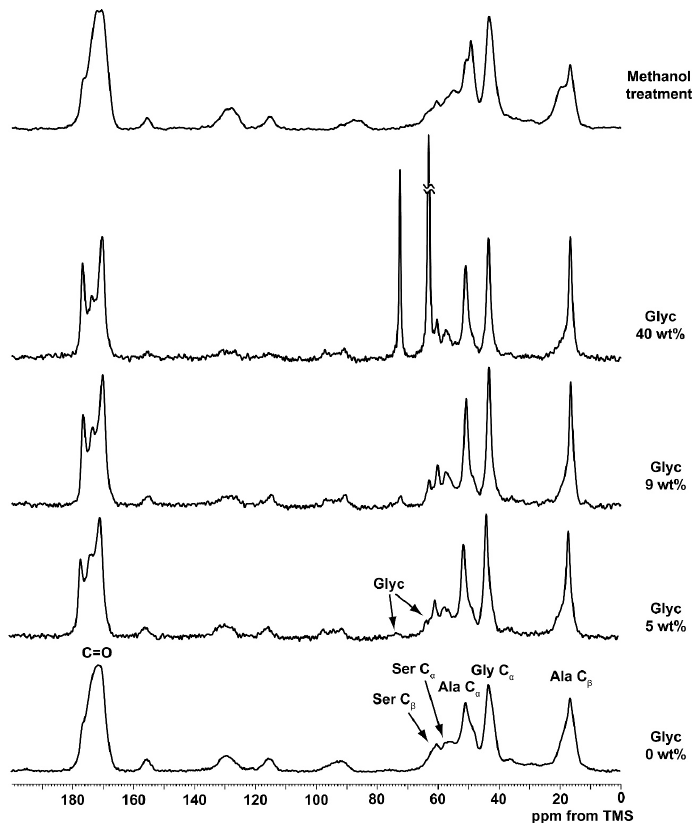
Figure 1. 13 C Cross Polarization/Magic Angle Spinning nuclear magnetic resonance (CP/MAS NMR) spectra of pure silk fibroin (SF) and glycerin (Glyc)-blend SF films with different Glyc concentrations of 5, 9, and 40 wt % and pure SF film treated by methanol. The assignments are given on top of the peaks. TMS, tetramethylsilane. Table 1. 13 C and 1 H chemical shifts (in ppm from tetramethylsilane (TMS)) of silk fibroin (SF) with different conformations in glycerin (Glyc)-blended SF film. The assignments of the conformations were performed as shown in the references [13,14,17,20–22,33] for 13 C nuclear magnetic resonance (NMR) and [32] for 1 H NMR.